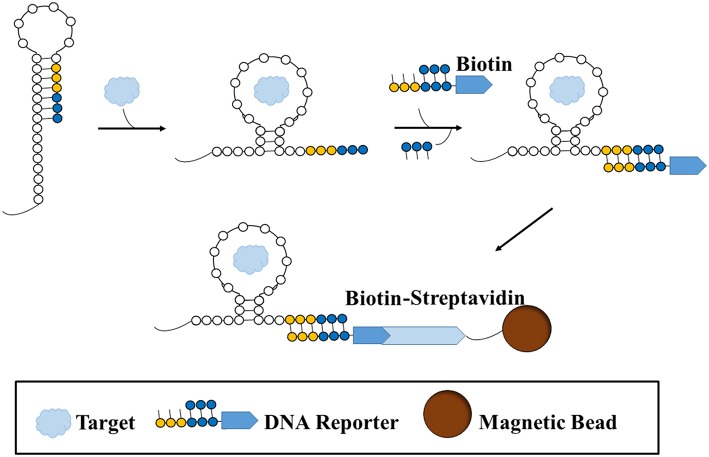
A type of structure-switching SELEX for aptamer selection. A sequence is folded in such a way that a binding site (yellow-blue) is hidden. Once target is introduced and bound to the sequence, the sequence undergoes a structural shift that exposes the binding site, such that a biotin-labeled double-stranded DNA reporter is free to bind to the site. Since the reporter preferentially binds to the binding site on the sequence, the shorter strand on the reporter becomes displaced. Thus, the sequence that binds the target and results in a structural shift becomes labeled with a biotin reporter. The sequence is then sequestered and separated from non-binding or non-shifting sequence structures with a streptavidin-conjugated magnetic bead.